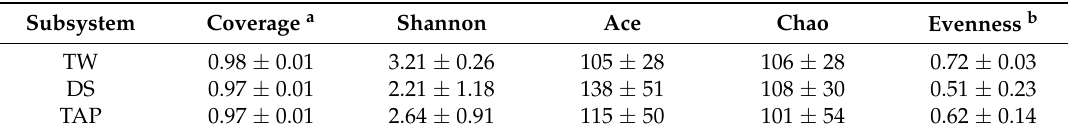
Figure 2. Box plots showing the water quality across the subsystems (treated water (TW), distribution system (DS), and building plumbing (TAP)): ( A ) Free chlorine, ( B ) water residence time, and ( C ) log of total bacterial counts. Table 1. Average estimators and standard deviation of alpha-diversity for treated water (TW), distributed water (DS), and tap water (TAP).